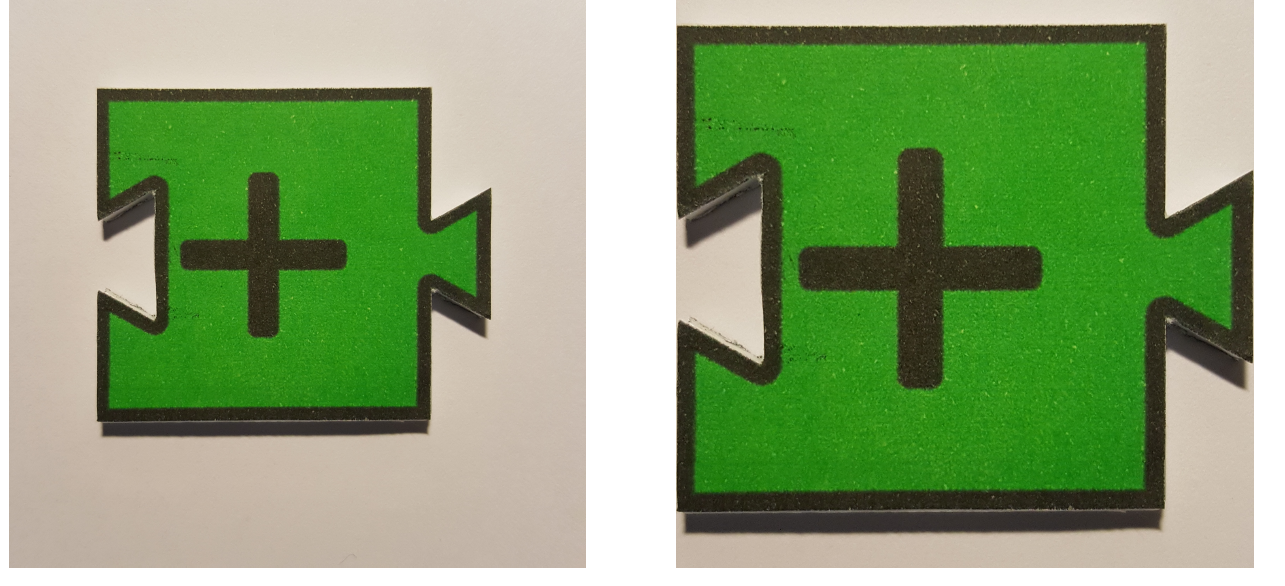
Figure 4. Two images of the tile “addition” for the training the